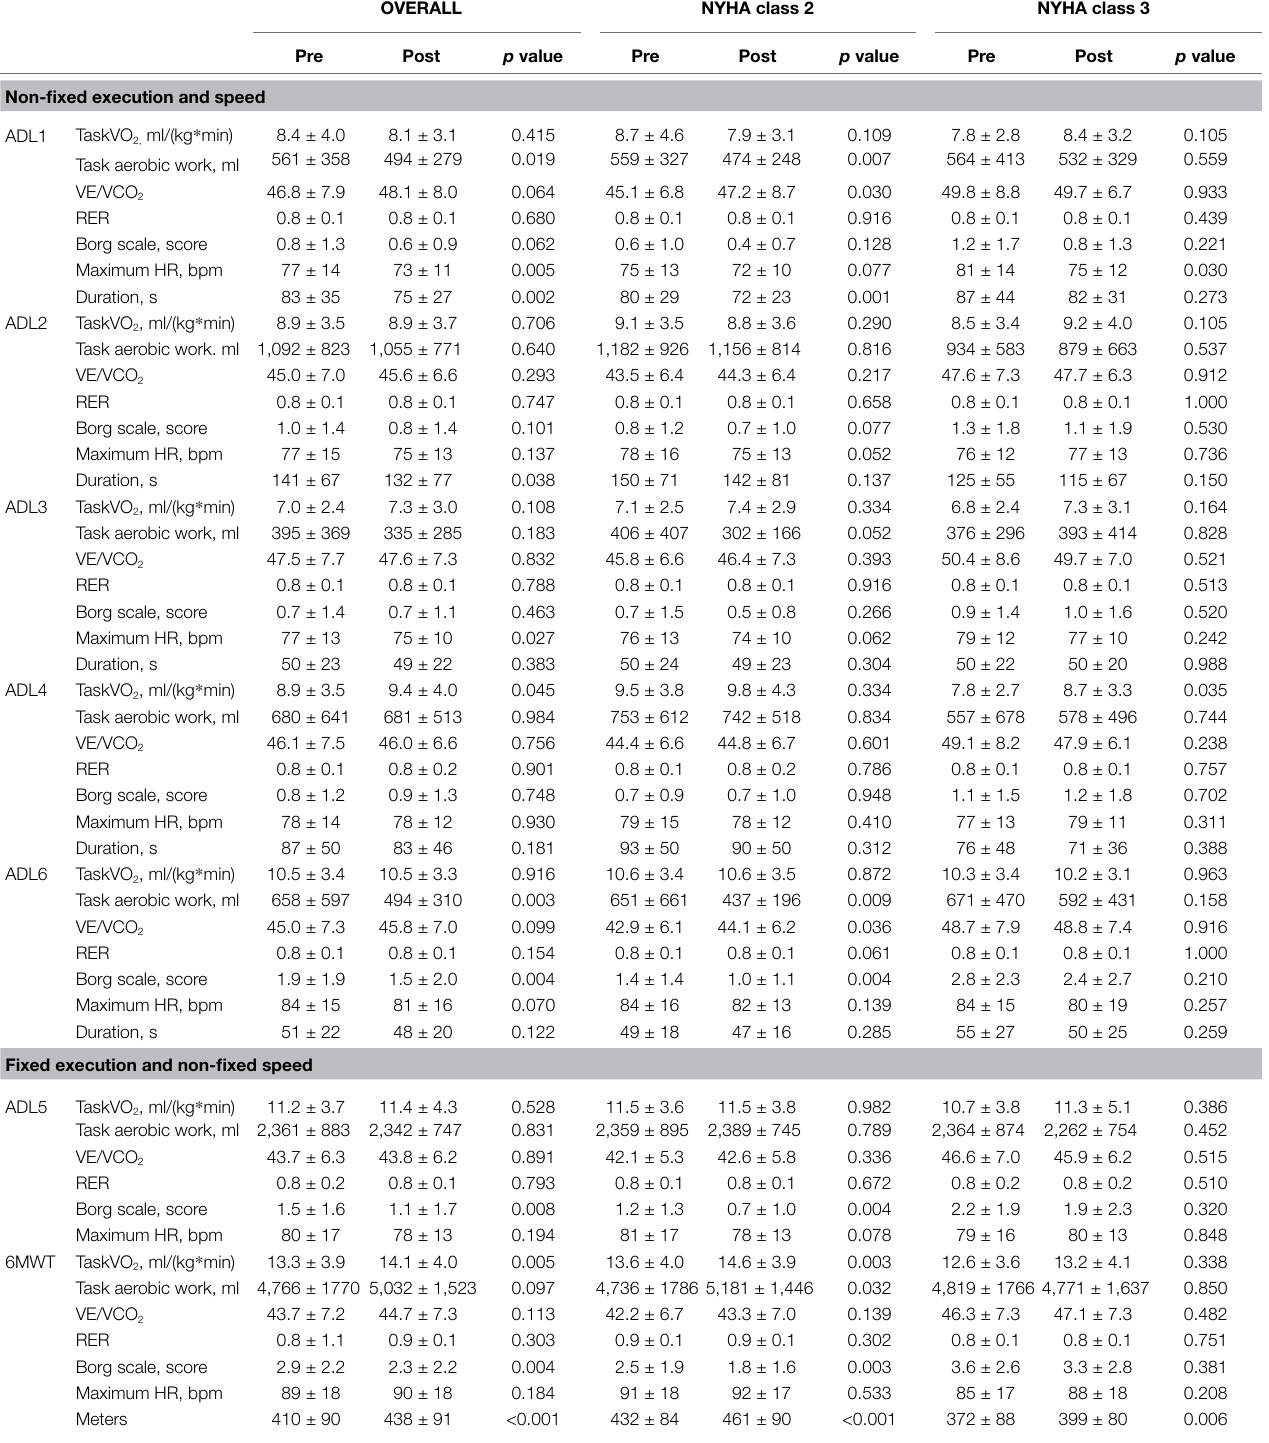
TABLE 2 | TaskVO 2 and aerobic work, VE/VCO 2 , Respiratory exchange ratio, Borg Scale and exercise parameters before and after